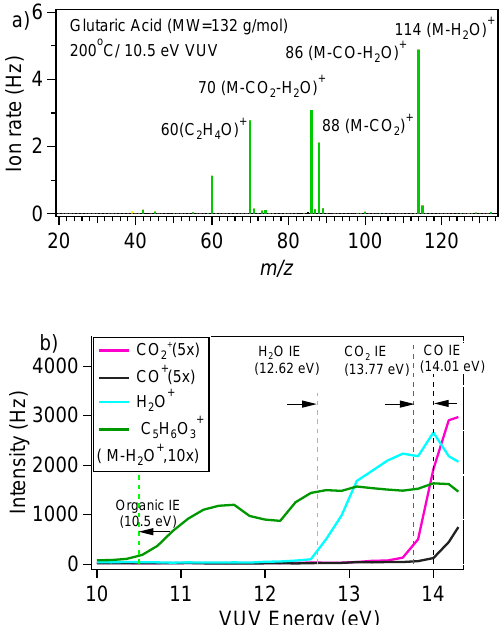
Figure 4. VUV-AMS spectrum of glutaric acid obtained under an argon atmosphere. The spectrum was obtained at a VUV energy of 10.5eV and a vaporizer temperature of 200 ◦ C. Ions corresponding to loss of CO 2 , CO, and H 2 O moieties from the parent ion (M + ) are observed. (b) Glutaric acid VUV-AMS signals as a function of VUV monochromatic photon energy. The signal intensity of C 5 H 6 O + which corresponds to the [M-H 2 O] + ion, and the signal intensities of CO + , CO + , H 2 O + are shown. The gas phase ionization energies 2 (IE) for neutral CO 2 , CO, and H 2 O molecules are shown as colored vertical